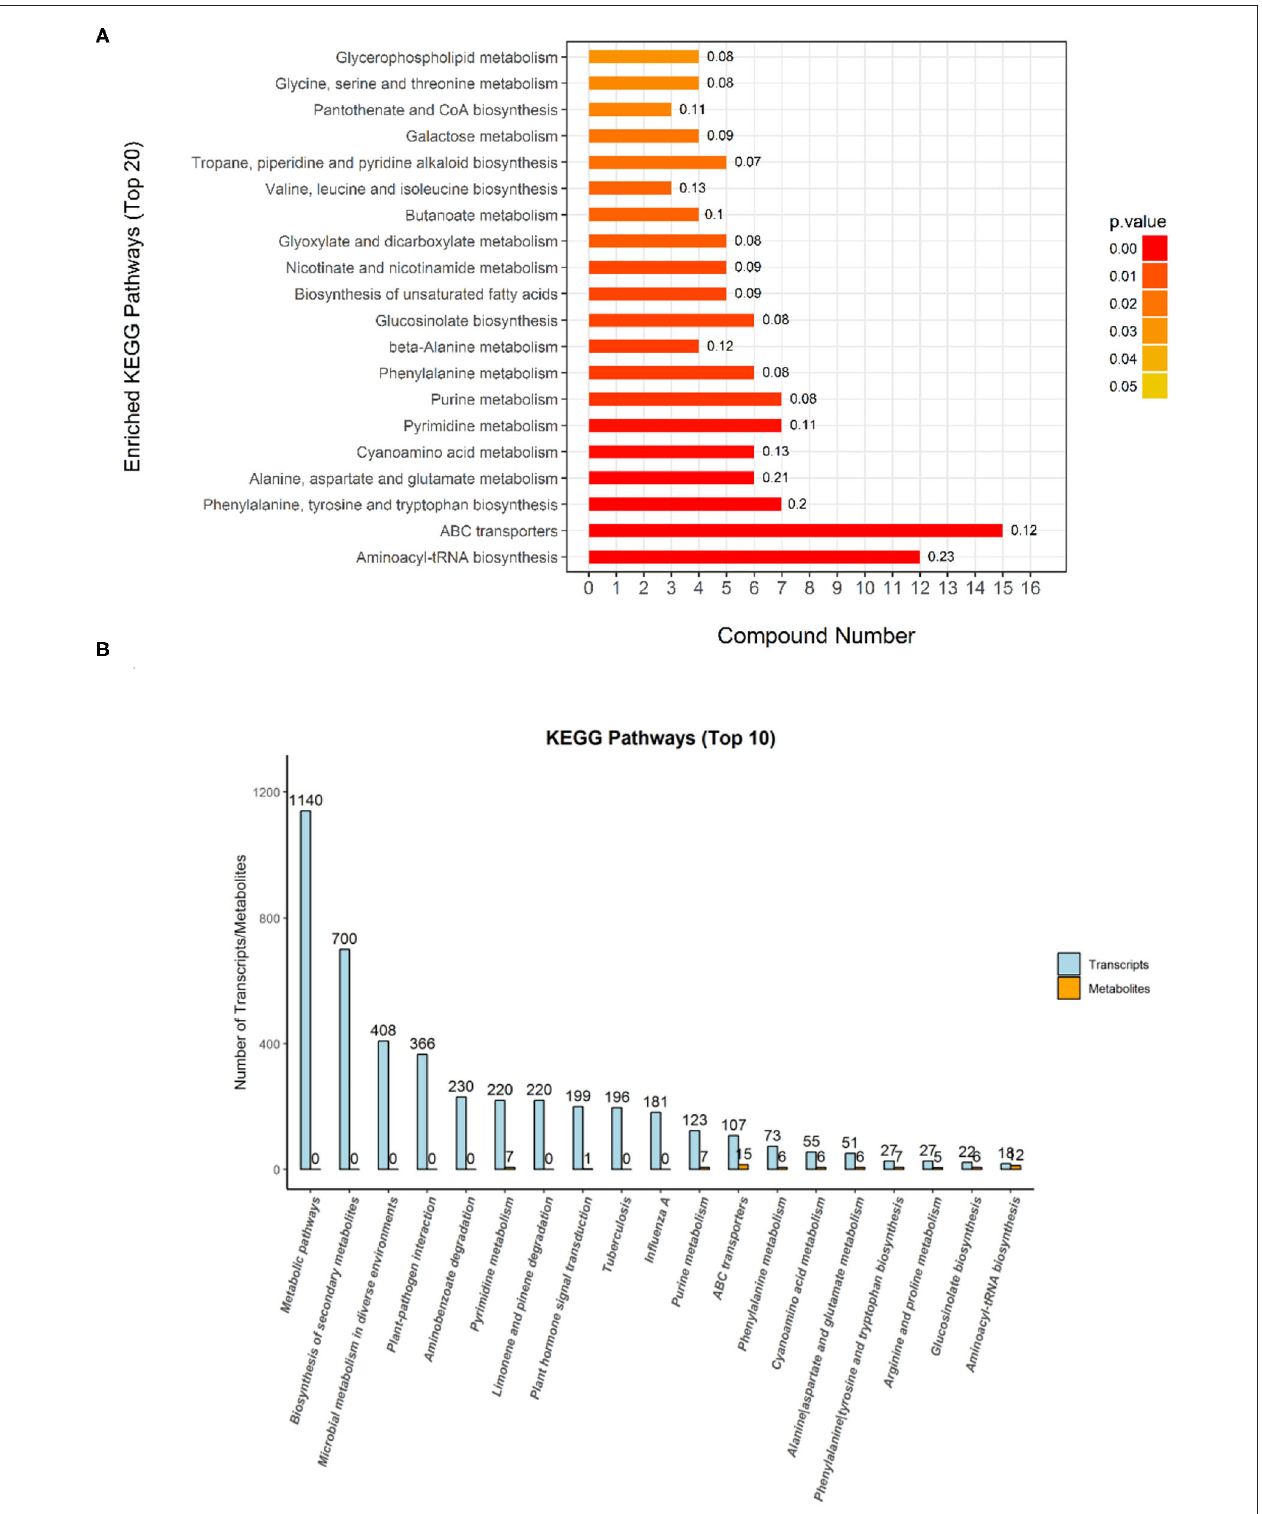
FIGURE 5 | The Kyoto Encyclopedia of Genes and Genomes (KEGG) classification of the differential metabolites (A) and transcriptomes (B) between DN and DS. The metabolic pathways annotated in KEGG are classified according to the type of pathway. The Abscissa is the number of metabolites annotated to that pathway and the ratio of the number of metabolites annotated to the total number of annotated metabolites in the corresponding pathway. DN is DXWR without salt treatment and DS is DXWR under salinity.